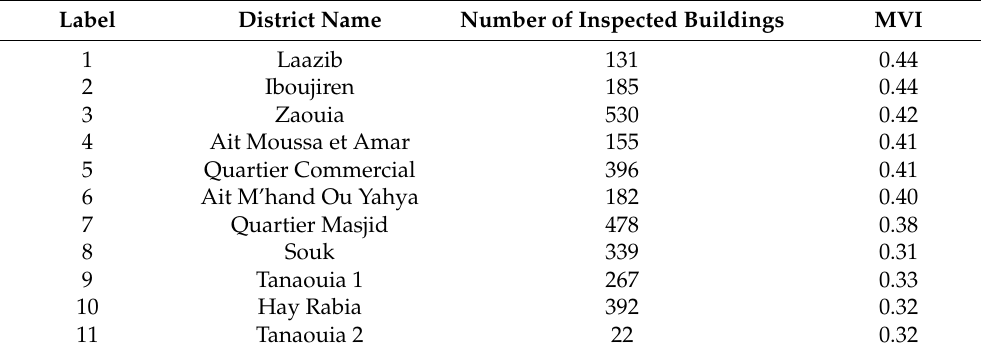
Figure 7. Vulnerability index values for the existing buildings in Imzouren. Table 4. Mean Vulnerability Indices (MVI) for the Districts of